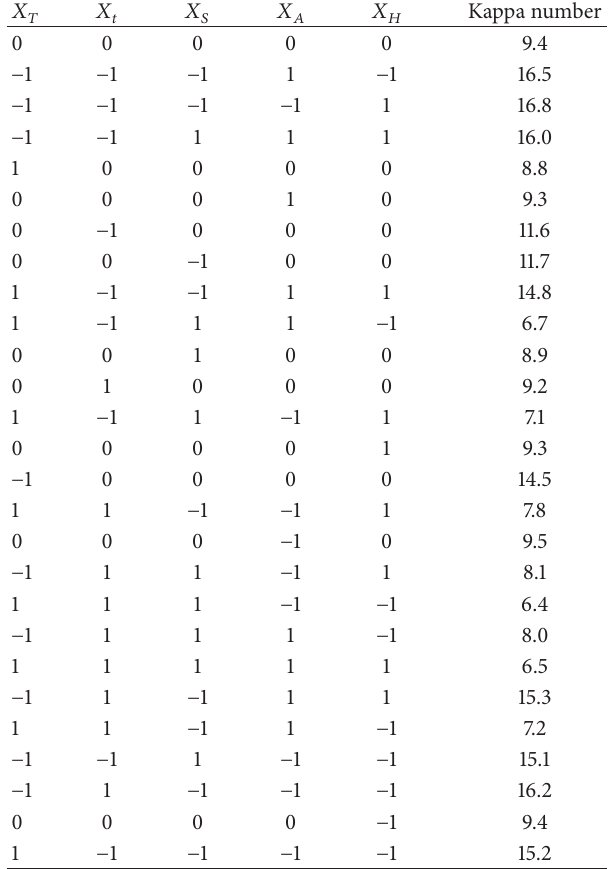
Table 2: Kappa number values obtained by iodometric titration for the different operating variables of the experimental design.